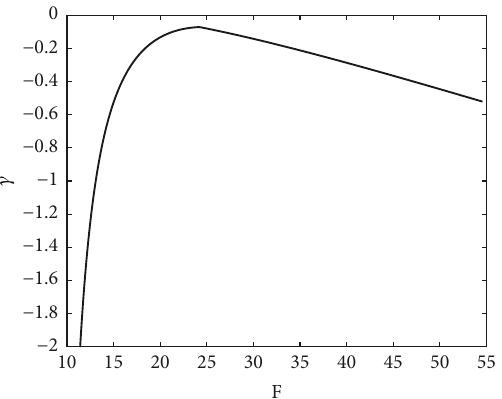
Figure 12: The graph of 𝛾 confer (B.5), in case of 𝐺 > 4.59